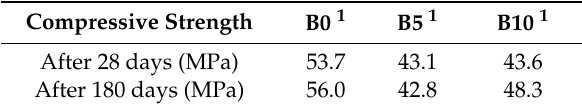
Table 5. Average compressive strength of concrete composite fcm.